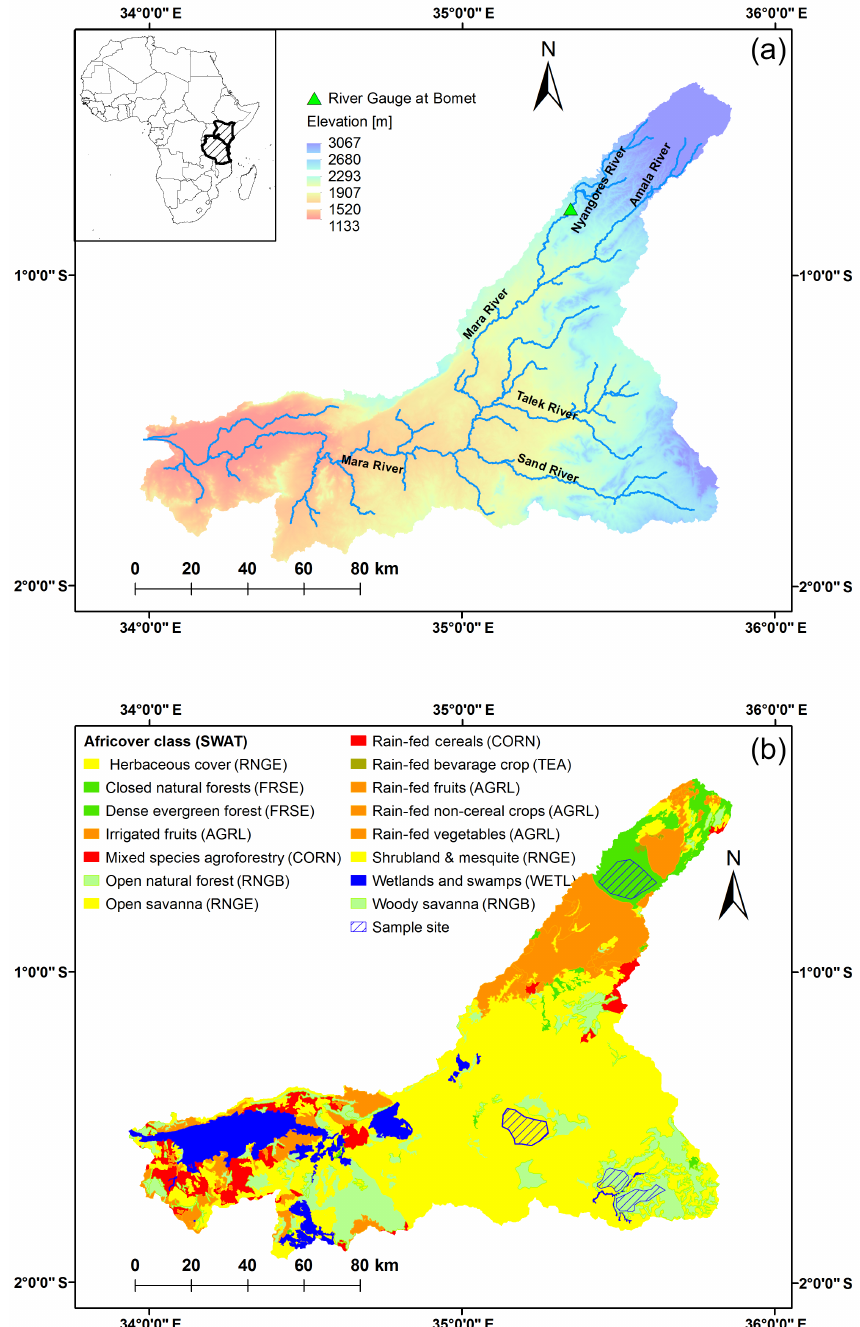
Figure 1. The Mara Basin (a) and its land cover classes (b) . Note the sample site locations (dashed areas) for the major natural vegetation classes that are used to mask the Moderate Resolution Imaging Spectroradiometer (MODIS) leaf area index